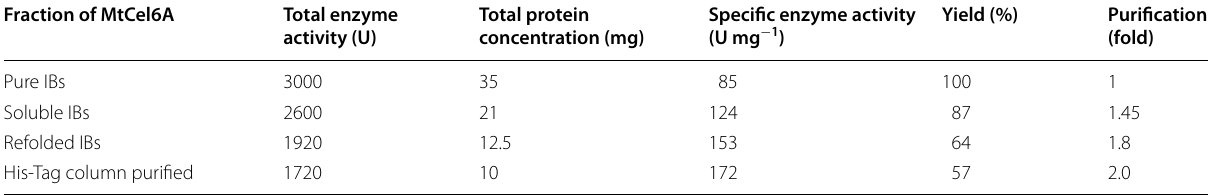
Table 1 Purification profile of